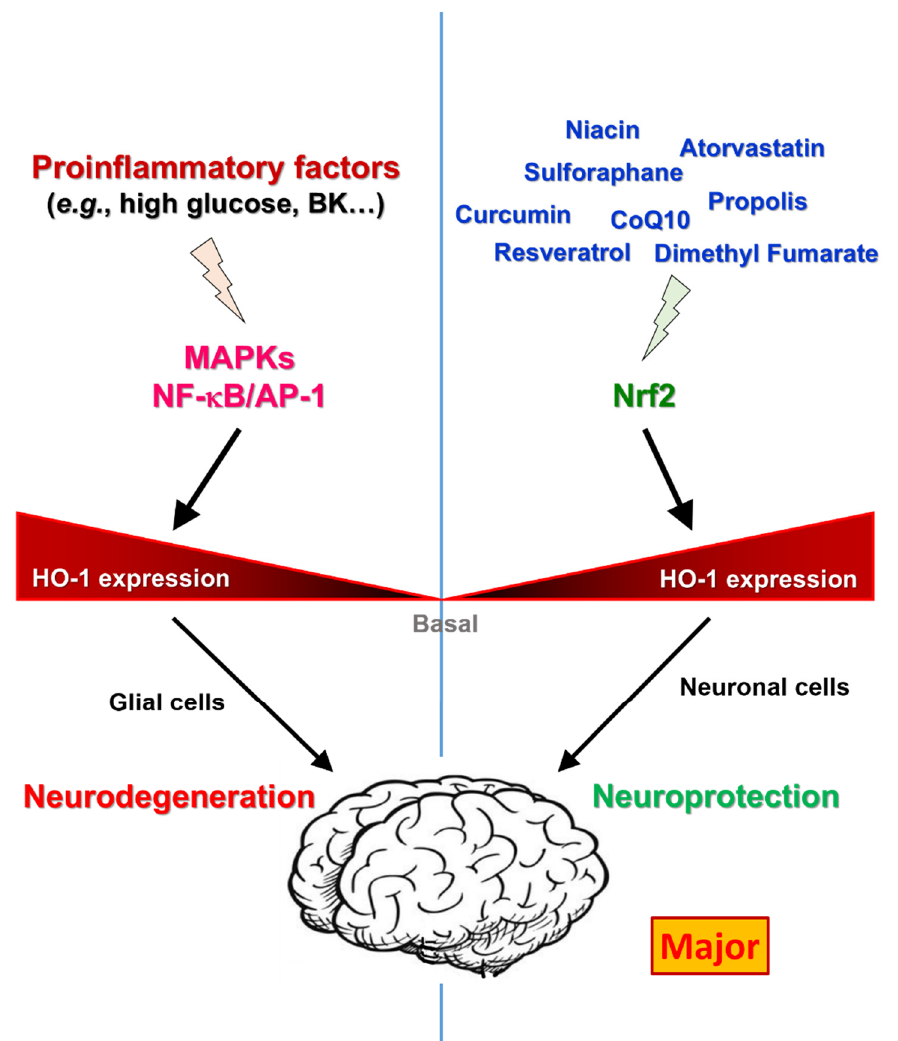
Figure 2. Schematic representation of the HO-1 regulation and its role in the procession of neuro- degeneration and neuroprotection. In neurodegeneration, proinflammatory factors induce HO-1 expression via MAPKs, NF- κ B, and AP-1 in glial cells. However, several herbal medicines induce HO-1 expression via Nrf2-dependent pathway in neuronal cells, indicating the major route of HO-1 induction for neuroprotective function. Thus, in brain, the final impact of upregulated HO-1 is depend on the stimulatory factors, the activated signaling pathways, and the stimulated cell-type.